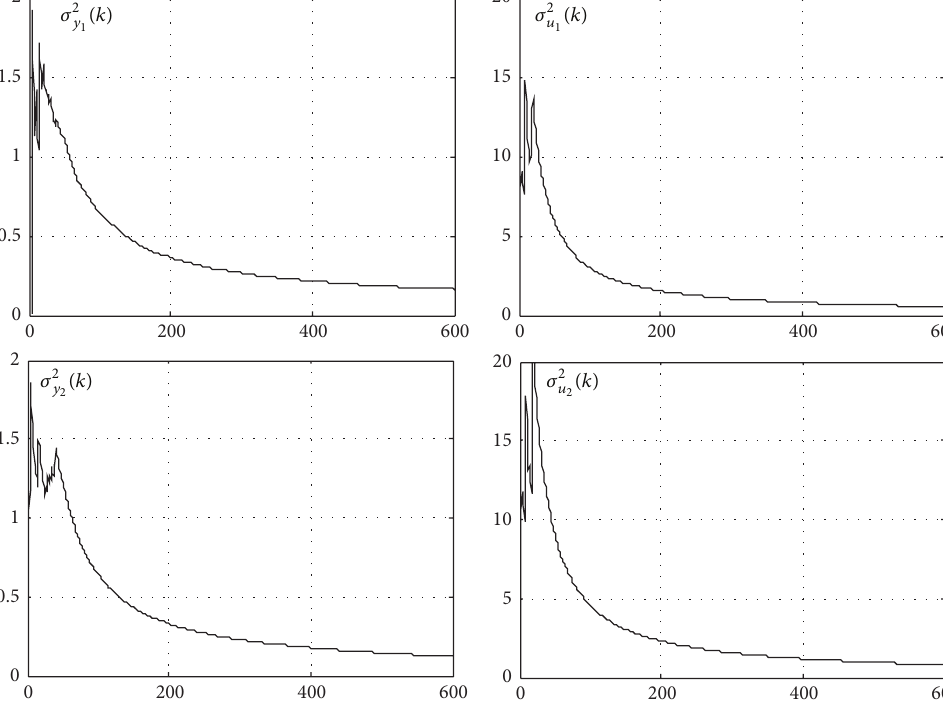
(𝑘) and 𝜎 2 (𝑘) 𝑢 1 𝑢 2